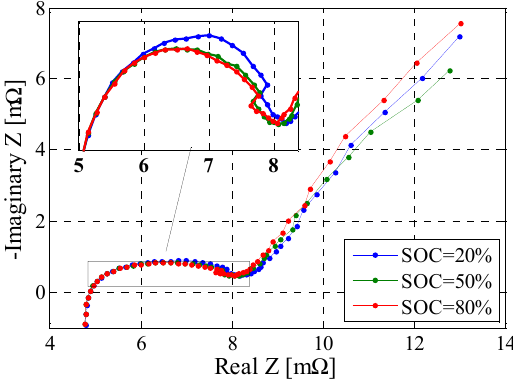
Figure 10. Dependence of the impedance spectra on the SOC ; T = 25 °C .